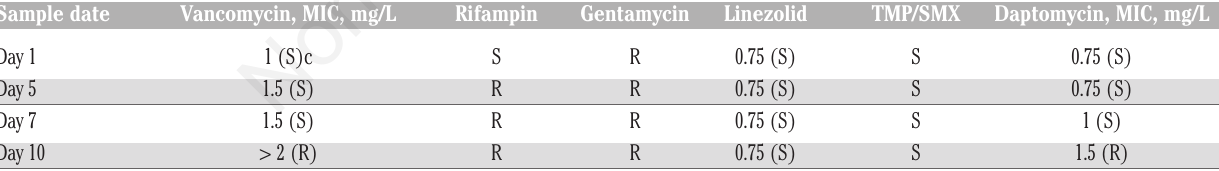
Table 1. Susceptibility testing of MRSA isolates during therapy with various antimicrobial agents.